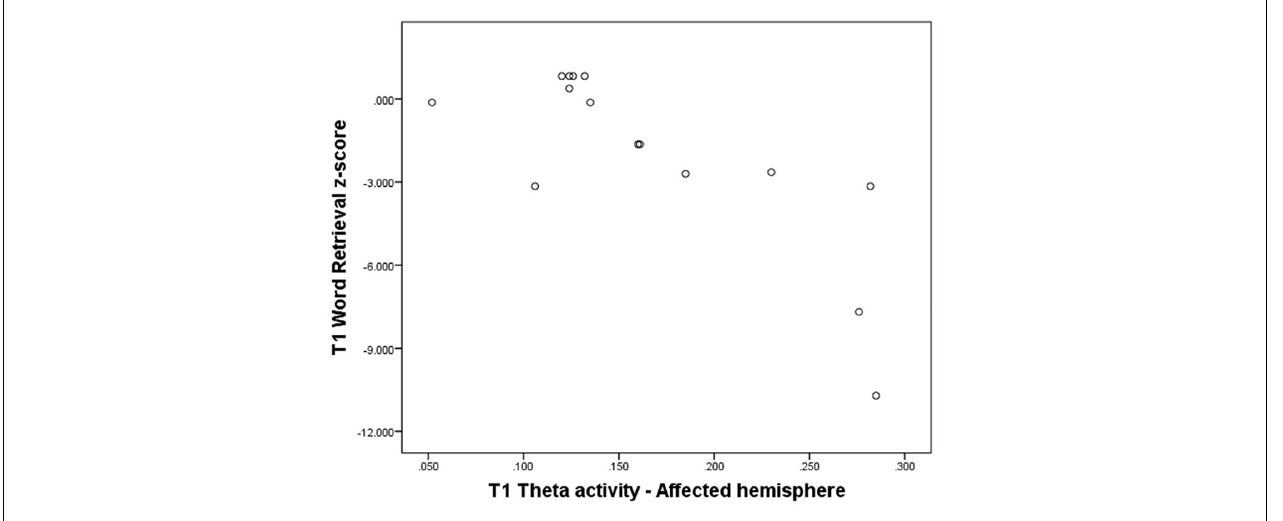
FIGURE 3 | Theta activity over the affected hemisphere at T1 - Word retrieval domain z-score at T1 ( N =